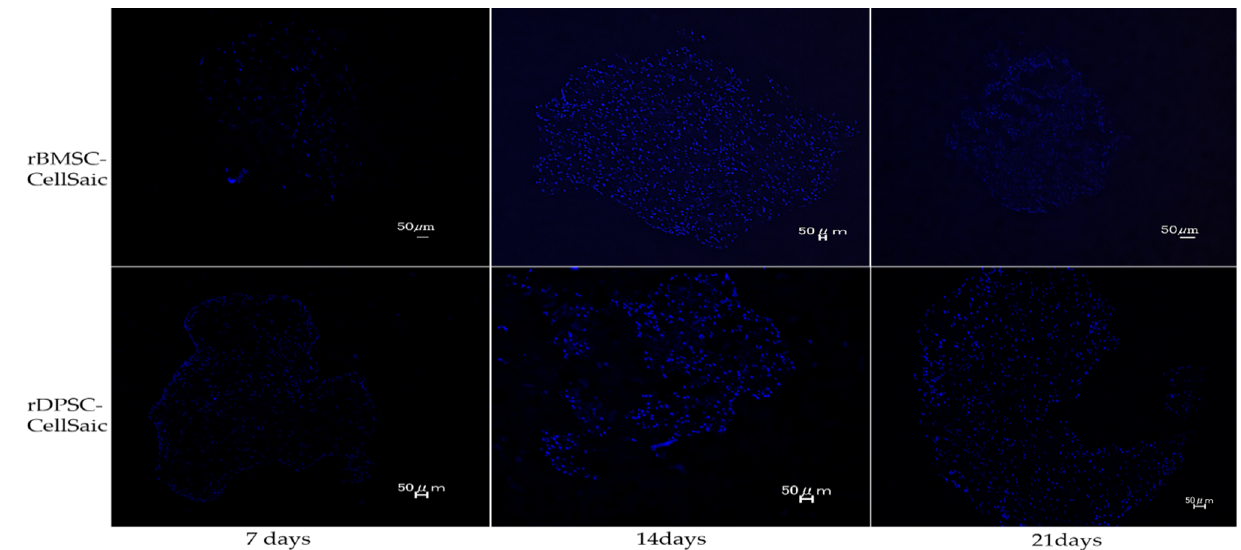
Figure 7. DAPI staining confirmed the presence of cells inside CellSaic after culturing for 7, 14, and 21 days (Slice thickness = 5 µm, Scale bar = 50 µm).